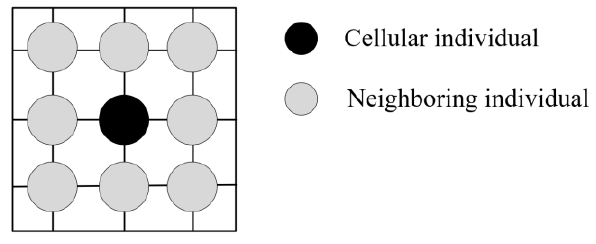
Figure 4. Layout of cellular and neighboring individuals.